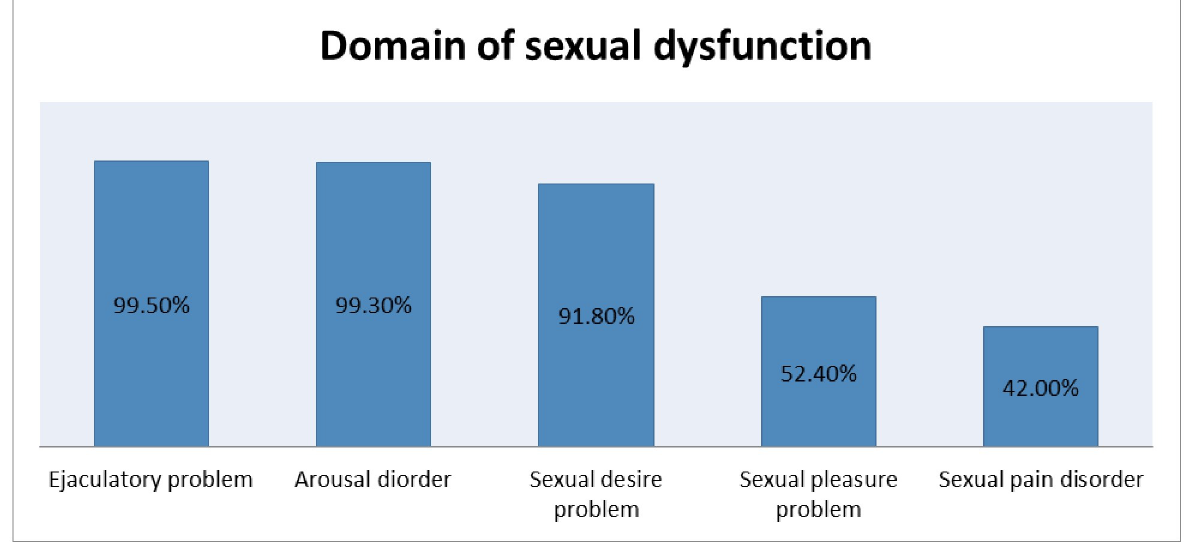
Fig 1. Domains of sexual dysfunction among men with diabetes at the three hospitals of Northwest Amhara region, Ethiopia from February 20–April 15, 2020.